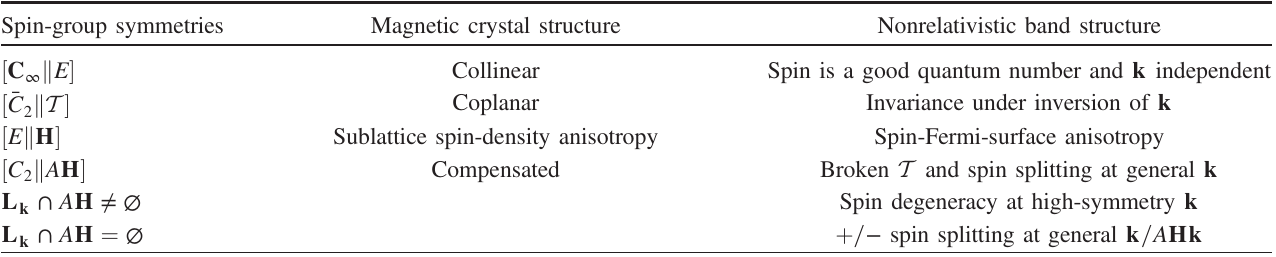
TABLE II. Spin-group symmetries and corresponding magnetic crystal-structure and nonrelativistic band-structure characteristics. The first two lines regard symmetries that apply to all three nonrelativistic collinear phases. The remaining lines apply only to altermagnets. For the definitions of symbols in the first column, see Sec. II B. This table is adapted from Ref.